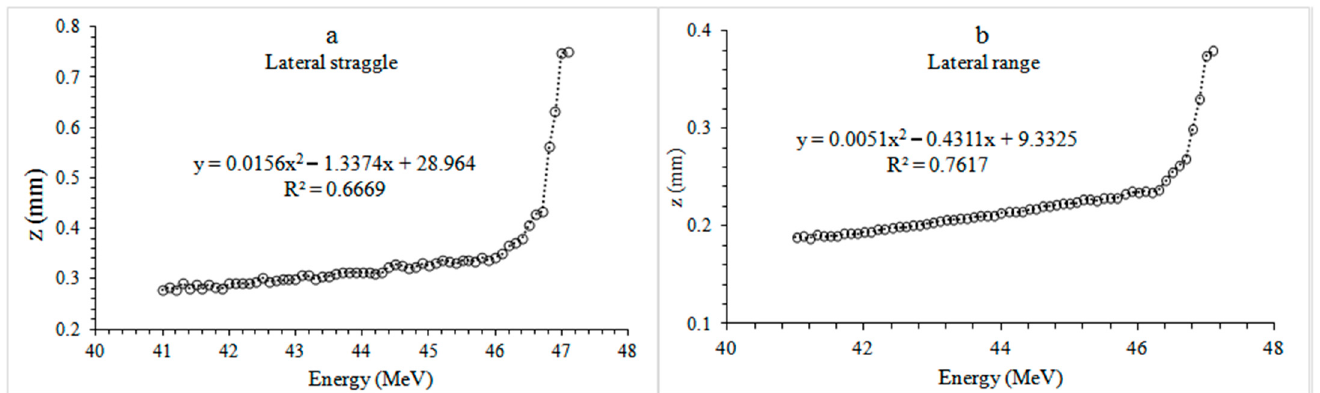
Figure 7. Recoils curves of different energy proton beams in dental plate phantoms. ( a ) Lateral straggle ( b ) Lateral range. Circles indicate lateral straggle and range for different energy levels.